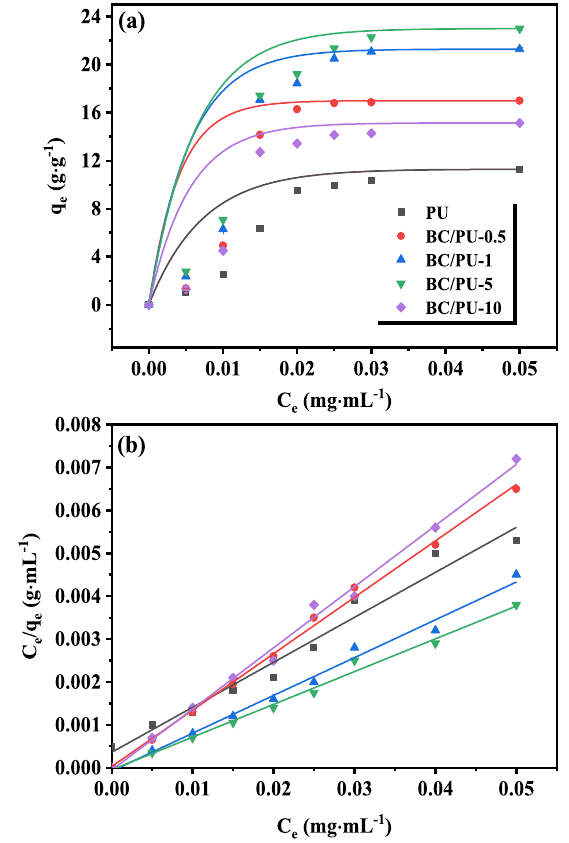
Fig. 8 Equilibrium n-hexane adsorption capacity (q of C e /q e versus C e base on Langmuir isotherm model ( b ) of BC/PU foam composites in aqueous solutions (foam sample of 0.1 g, 30 ℃ , and pH 7.0)